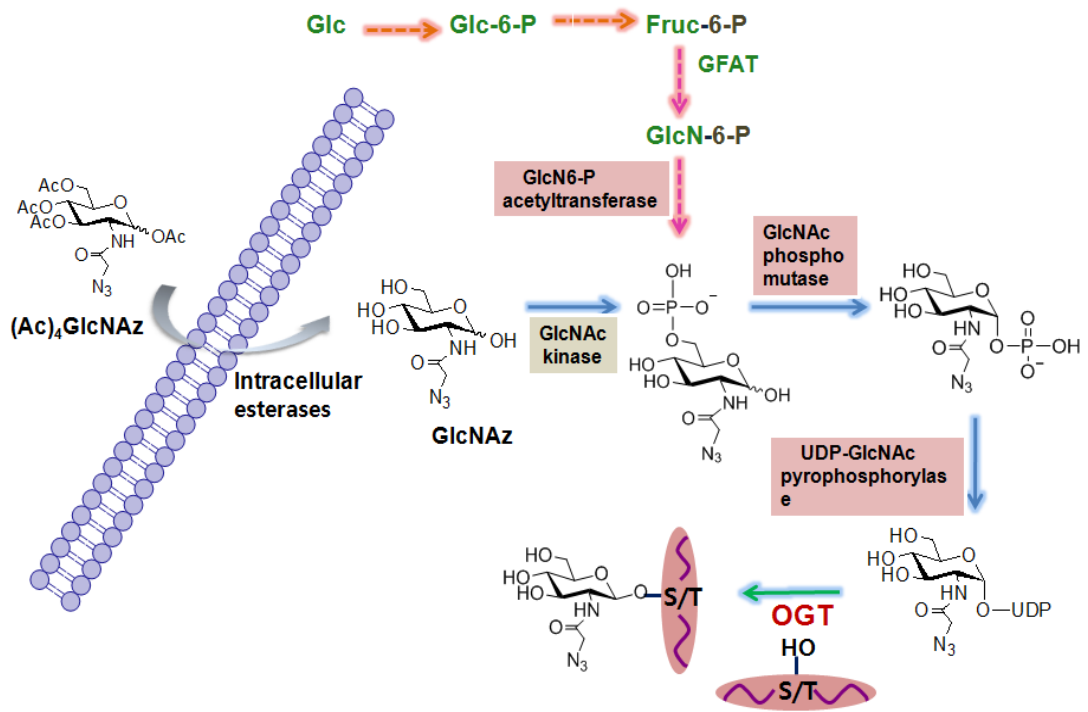
Figure 3. Metabolic labeling of carbohydrate strategies for the global identification of O -GlcNAc-modified proteins.